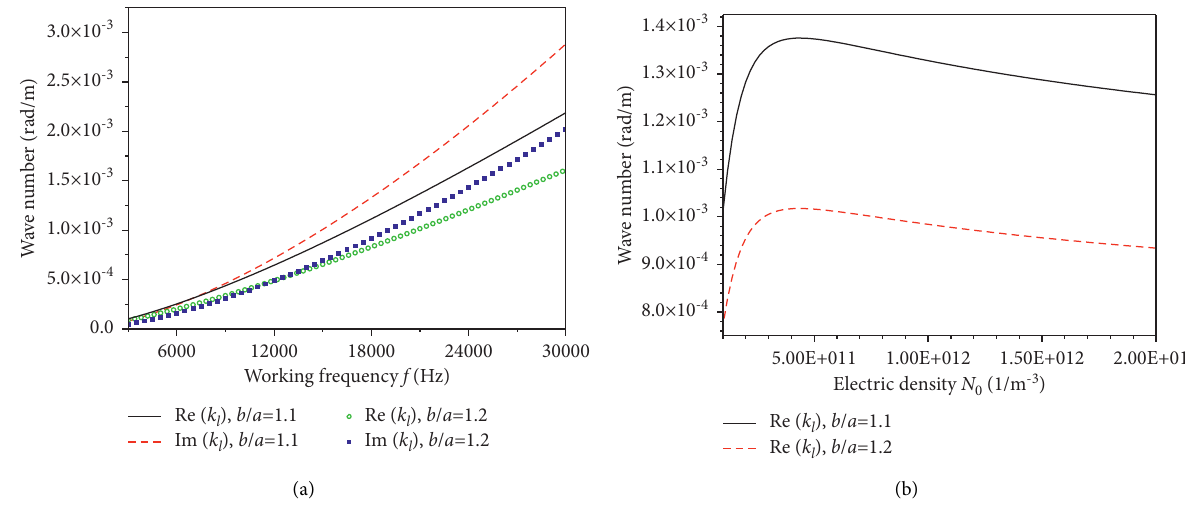
Figure 3: Wave number of an insulated antenna in an anisotropic ionosphere for various normalized insulation thickness (a) versus the working frequency and (b) versus the electric density of the ionosphere.